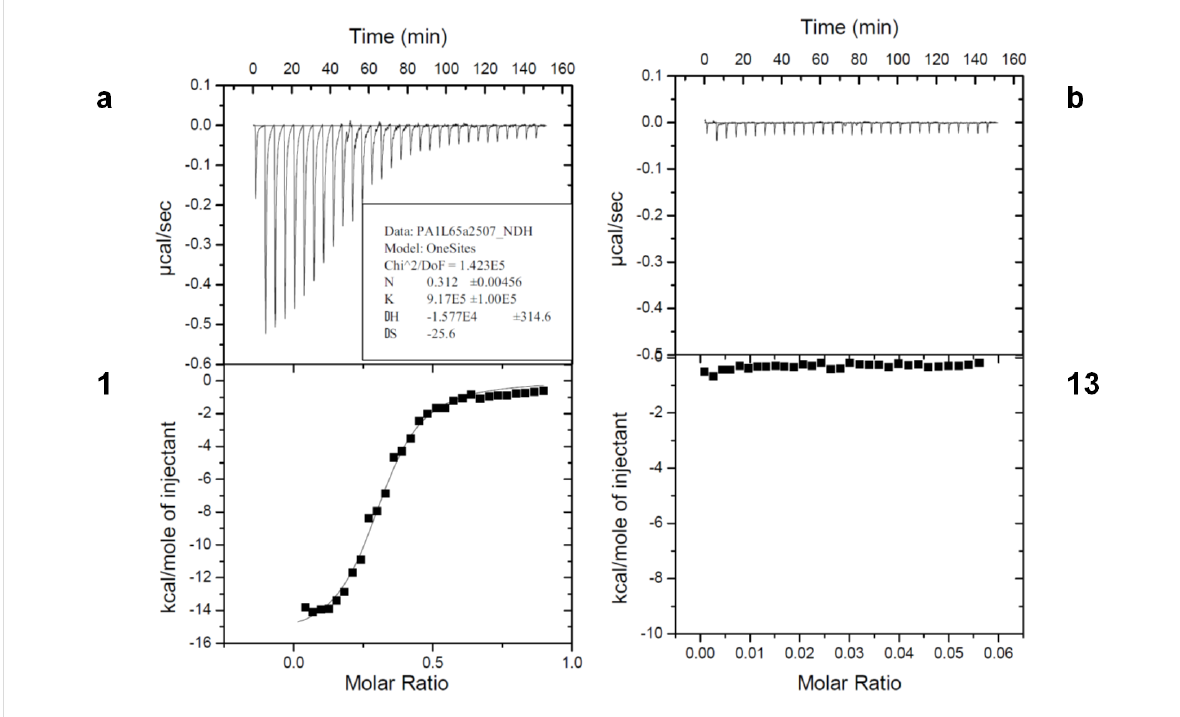
Figure 3: Typical ITC measurements representing the raw ITC data (top) and integrated titration curves (bottom) for the binding to lecA of a) tris-D- galactosyl triazine cluster 1 , and b) tris D-glucosyl glycocluster 13 (negative control).